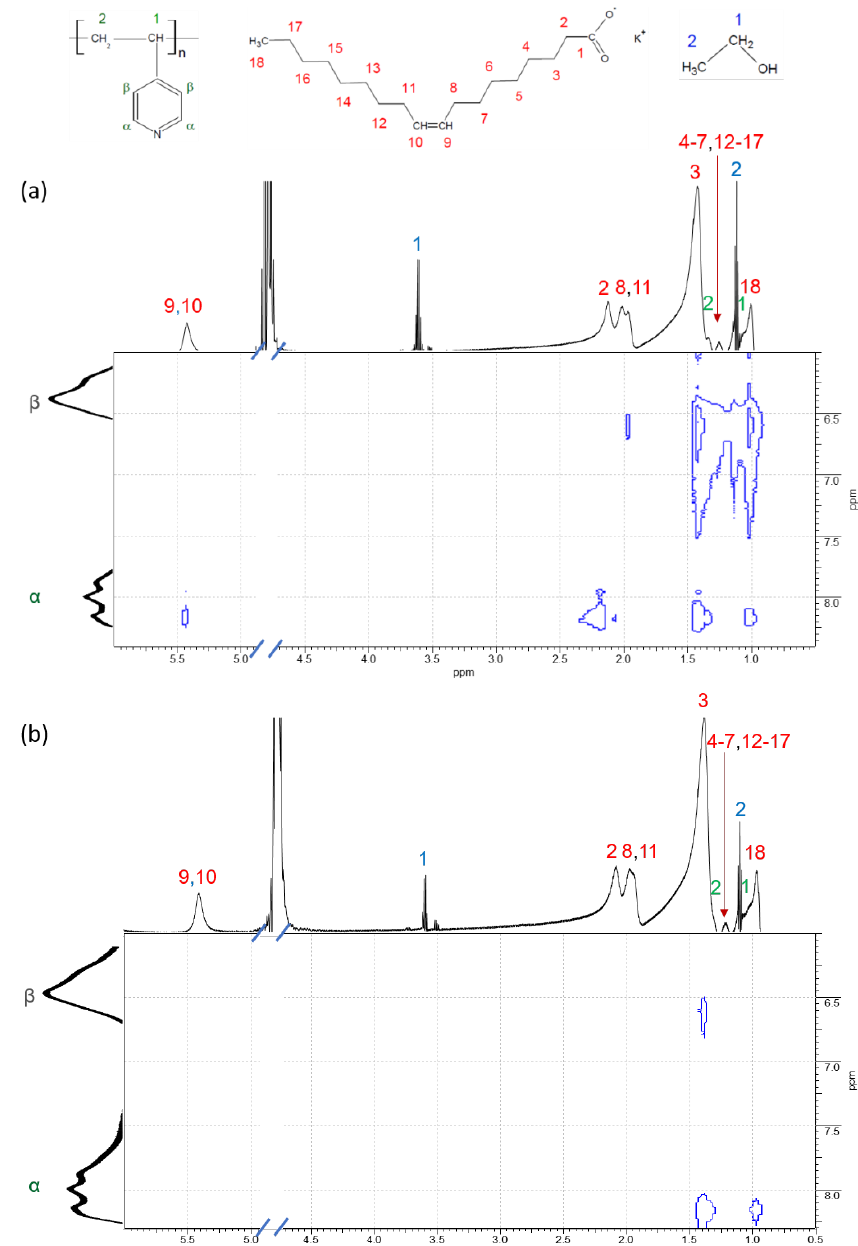
Figure 6. Cross-peaks of the 2D NOESY spectra for the saturated P4VP/potassium oleate complexes in the solutions containing 94 mM potassium oleate and different concentrations of salt KCl: 67 ( a ) and 160 mM ( b ). Solvent: D 2 O at pH = 11; t = 22 °C. The 1 H NMR peaks assignments of potassium oleate and P4VP were reproduced from reference [65] with permission of Royal Society of Chemis- try.